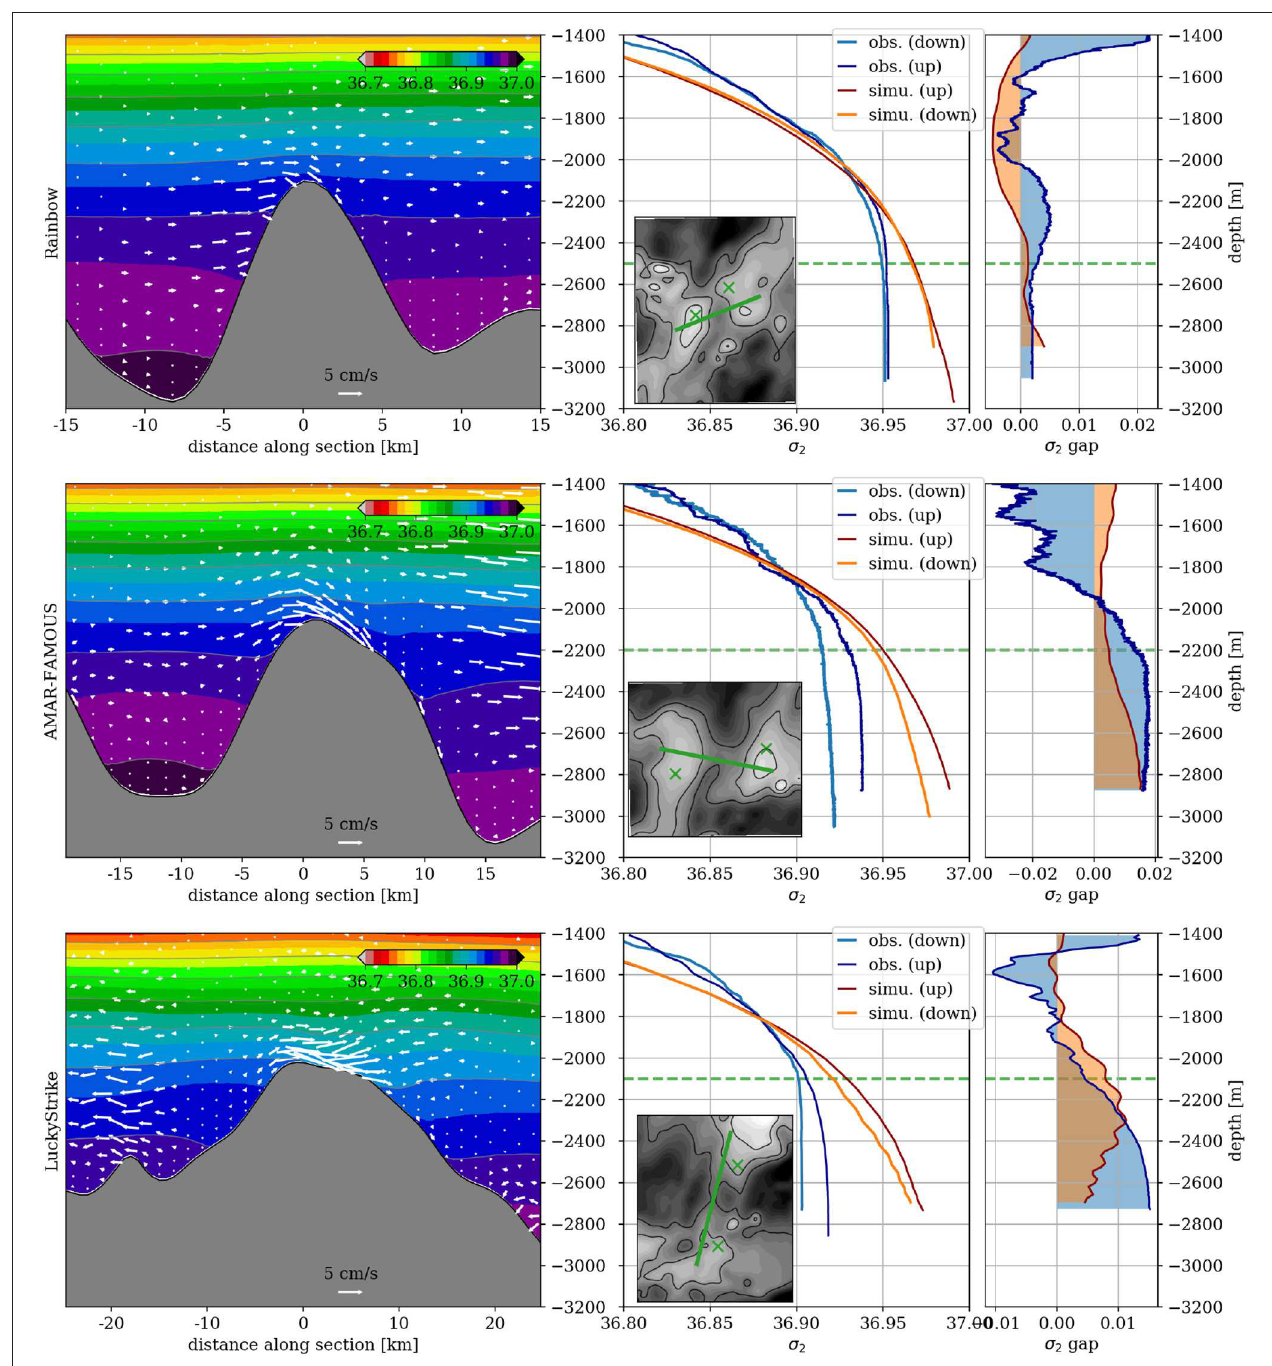
FIGURE 6 | Density changes across three prominent sills in the rift valley, namely the Rainbow sill near 36.25 ◦ N (upper row), the AMAR-FAMOUS overflow sill near 33.5 ◦ W, 36.5 ◦ N (middle row), and the Lucky-Strike segment center near 37.25 ◦ N (lower row). Left panels show mean potential density anomaly referenced at 2,000 m at vertical sections across the sill, together with the along-section component of the mean flow in white arrows. Location of the sections are indicated by green lines on the mapped bathymetry (gray) shown in the middle panels. Middle column: upstream (darker) and downstream (lighter) potential density vertical profiles from CTD stations (blue shade) and from the numerical simulation (red shade—3-month average). Right column: upstream—downstream potential density difference. The location of the profiles are indicated by green crosses in the inset maps of the middle panels. The dashed green horizontal line indicates the maximum depth of the sill. CTD profiles at the AMAR-FAMOUS passage are taken in 2007 (MOMARdream cruise) and are very similar to equivalent profiles in 1997 (Thurnherr and Richards, 2001, Figure 7A).